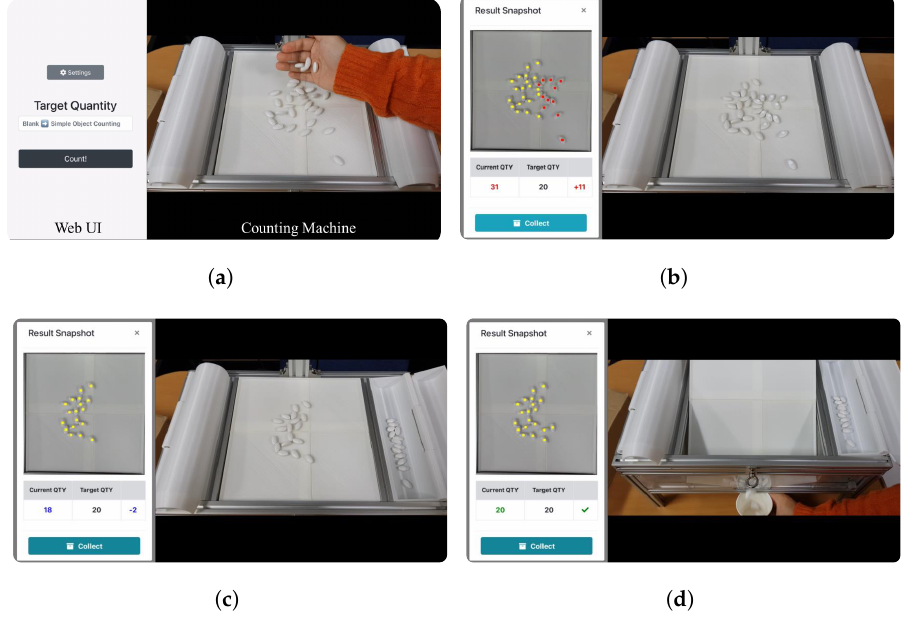
Figure 12. The snapshots of the scenario. The sub-figures are matched to the scenario in Table